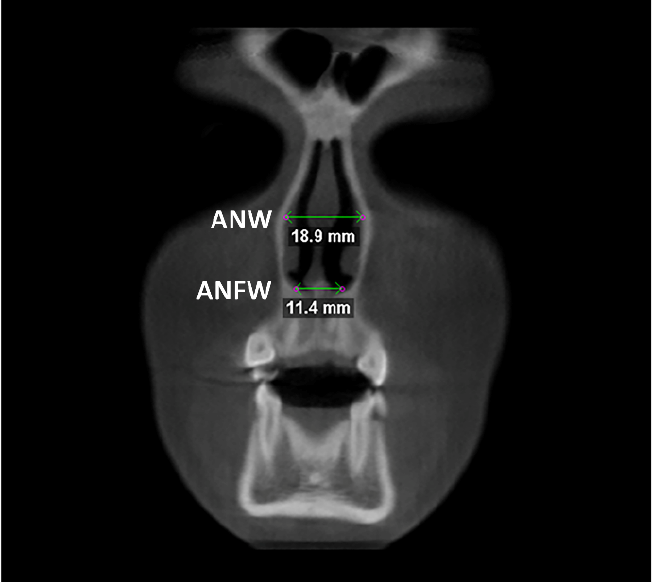
Figure 3. Linear measurements of anterior nasal width (ANW) and anterior nasal floor width (ANFW) in the coronal plane.